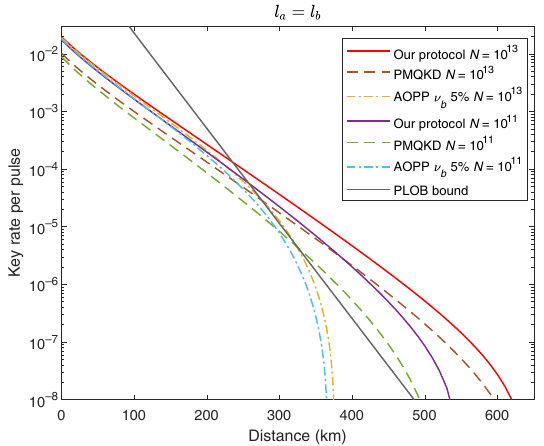
FIG. 9. Comparison of the secret key rates of the asynchronous MDIQKD with arbitrary time matching, PMQKD [40] and AOPP [81] in symmetric channels. The numerical results here show that our protocol has a notable advantage and is able to achieve a long transmission distance of 620